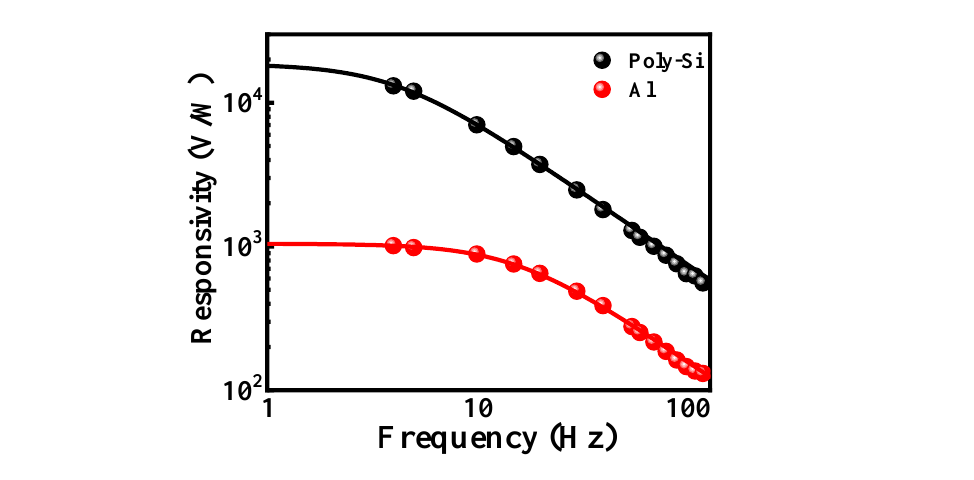
Figure 9. The responsivity measured in vacuum of the salicide polysilicon and metal Al microbolometer concerning modulation frequency.